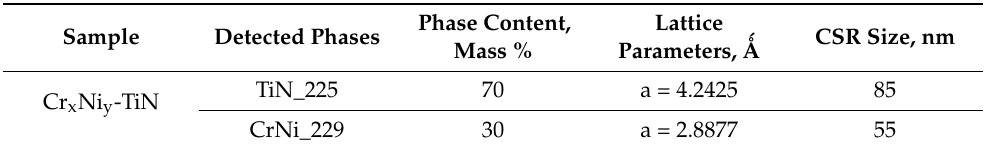
Table 5. Results of the energy dispersive analysis of the local areas in the structure of the materials obtained by direct laser deposition from CrNi-TiN SHS composites. Detected Elements, at. % Point No. (+) Ti N